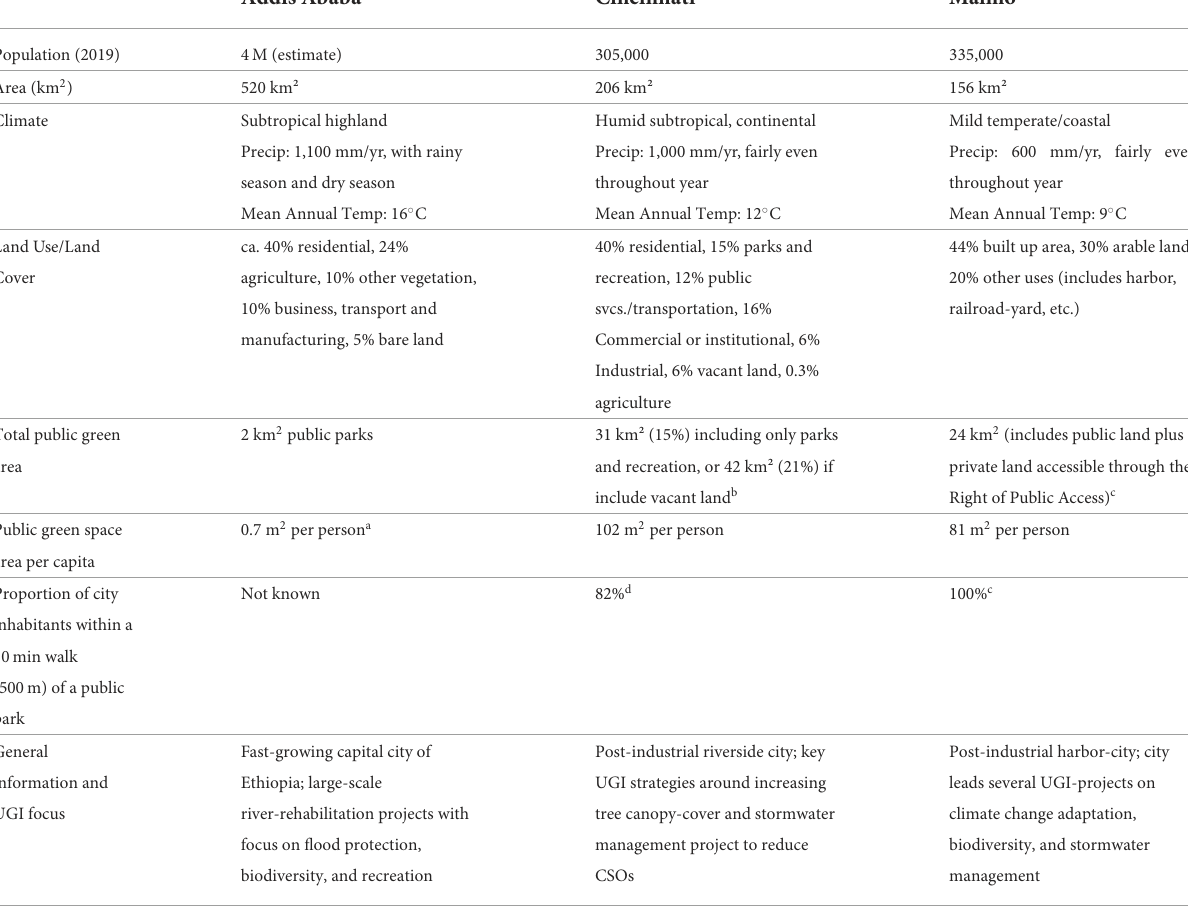
TABLE 1 Key UGI characteristics for the three case study